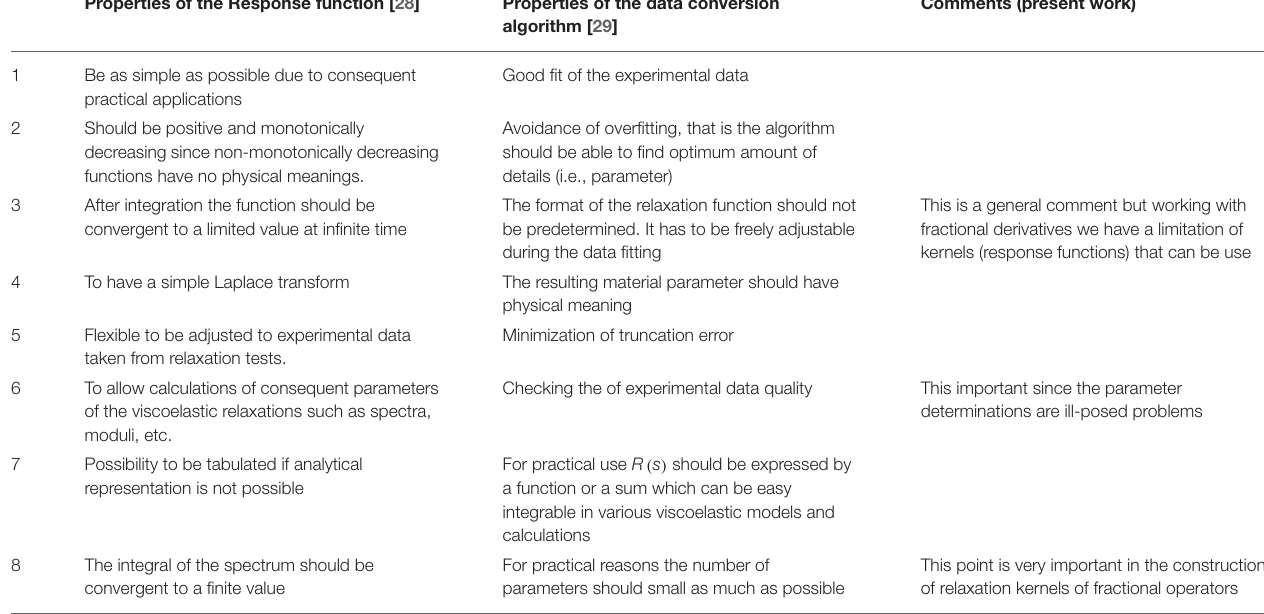
TABLE 1 | Response function desired